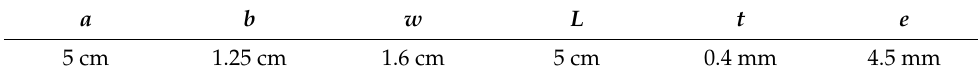
Figure 11. IC-Stripline cell based on image theory. ( a ) Three views. ( b ) The model established in CST. Table 2. Dimensions of the IC-Stripline cell based on image